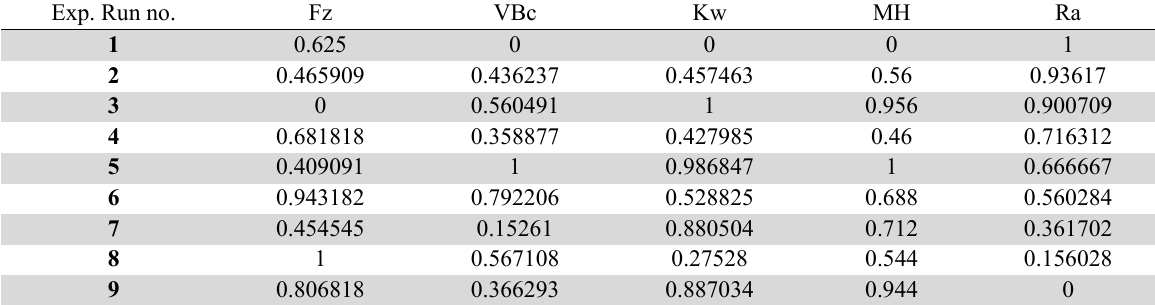
Correlation coefficient of the output responses VBc